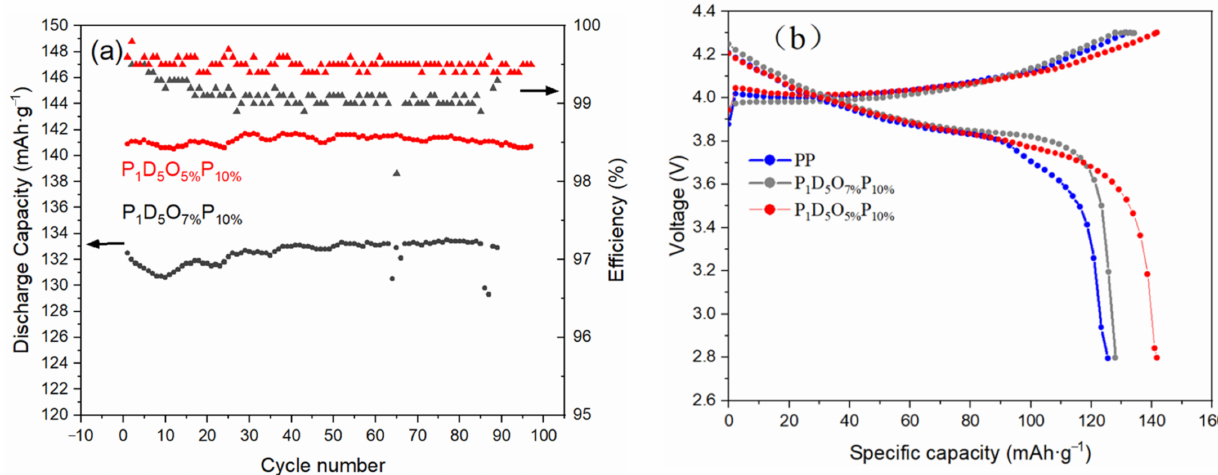
Figure 11. ( a ) Cycle performance; ( b ) Charge and Discharge curve of the first